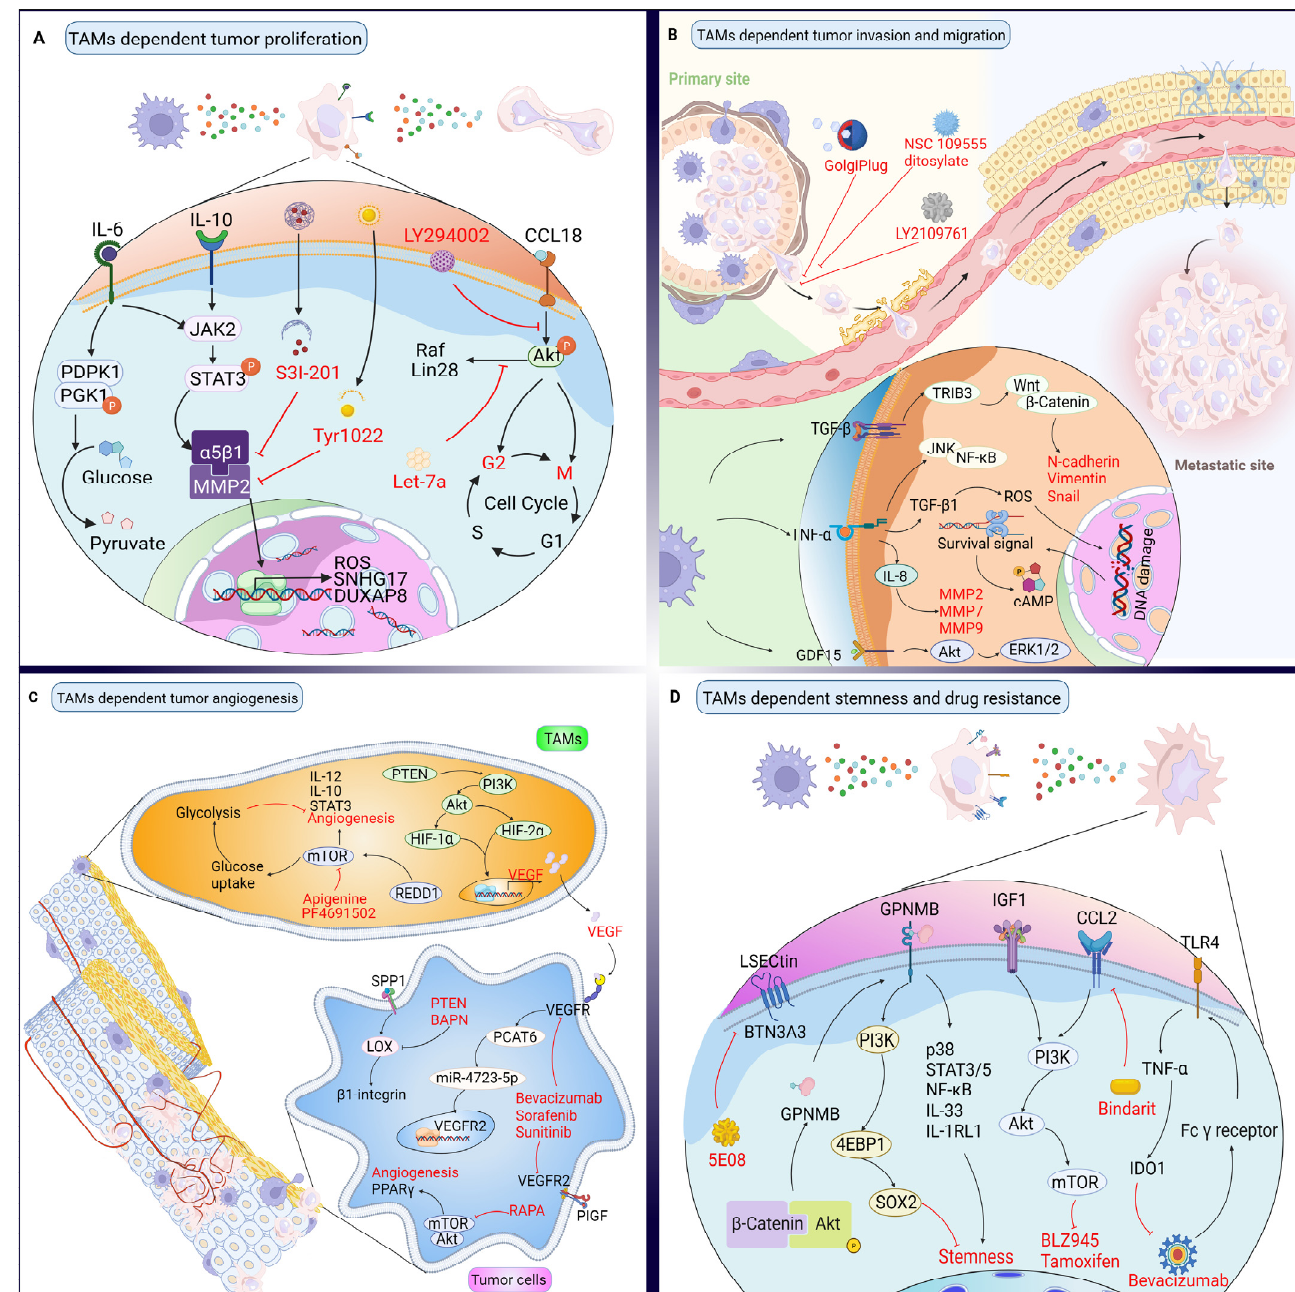
Figure 2. Targeting proteins in the crosstalk between TAMs and tumor cells. ( A ) In tumor cells, 3-phosphoinositide-dependent protein kinase 1 (PDPK1) is activated by TAMs derived IL-6, then phosphorylates phosphoglycerate kinase 1 (PGK1) to promote proliferation by pyruvate generation. TAM-derived IL-6 and IL-10 activate the JAK2/STAT3 cascade, then upregulate reactive oxygen species (ROS), SNHG17 and DUXAP8, to promote proliferation, while the S3I-201 and Tyr1022 could inhibit α 5 β 1 integrin and MMP2, respectively, to inhibit this process. Similarly, TAM-derived CCL18 could activate the Akt signal, then prolong the S phase and reduce the G1 phase of cell cycle, and promote the expression of Raf and Lin28. LY294002 and Let-7a could inhibit the activity of the Akt cascade. ( B ) Grow factors and cytokines, such as transforming growth factor-beta (TGF- β ), combine with their reporters in tumor cells, then activate the downstream effector, including cAMP and ROS, to promote the invasion and metastasis of tumor cells. The application of inhibitors, such as LY2109761, could block the invasion and metastasis of tumor cells. ( C ) Angiogenesis is regulated by several major signals, such as the PTEN/PI3K/Akt and mammalian target of rapamycin (mTOR) signaling pathways, and the TAM-derived vascular endothelial growth factor (VEGF) is also